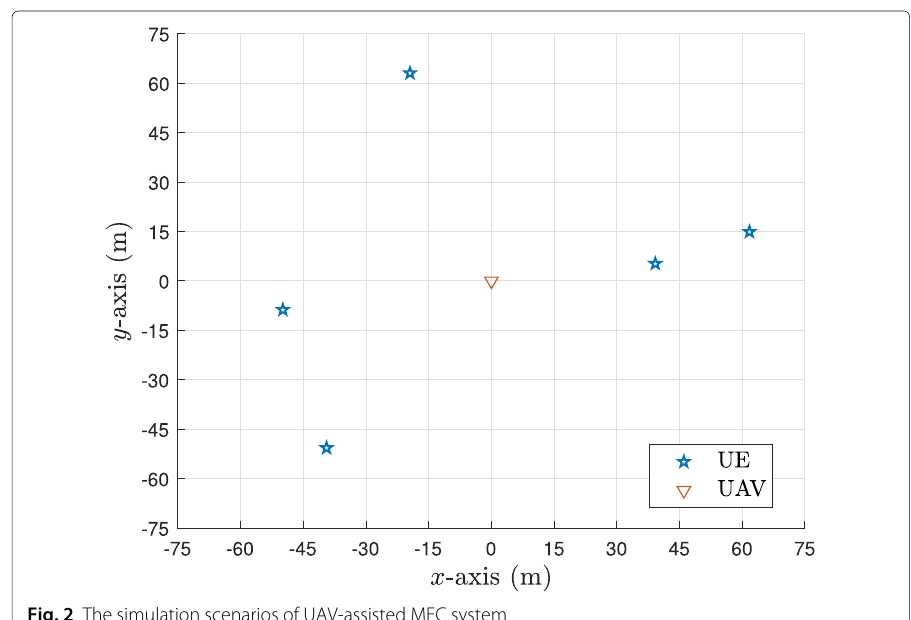
Fig. 2 The simulation scenarios of UAV-assisted MEC system